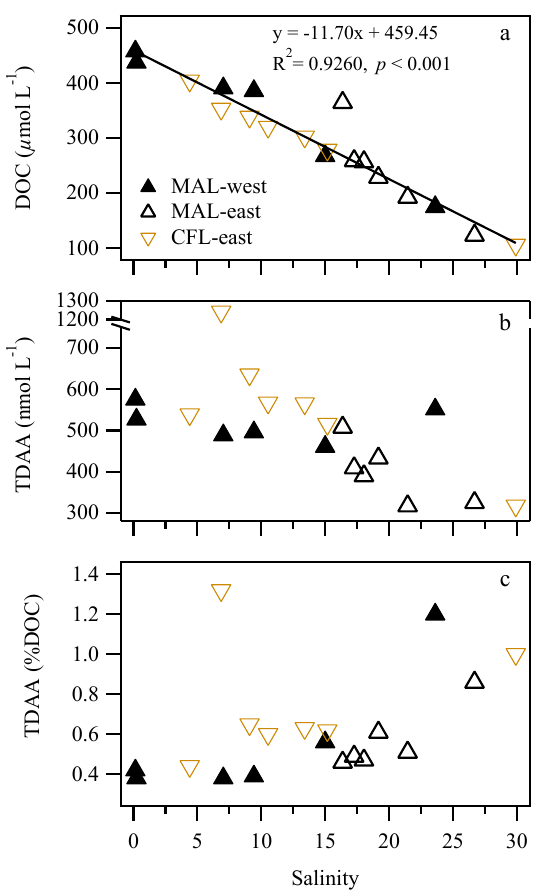
Fig. 2. Mixing patterns of DOM in the Mackenzie River plume. Dis- tributions of (a) dissolved organic carbon (DOC), (b) total dissolved amino acids (TDAA), and (c) yields of TDAA (%DOC) across the salinity